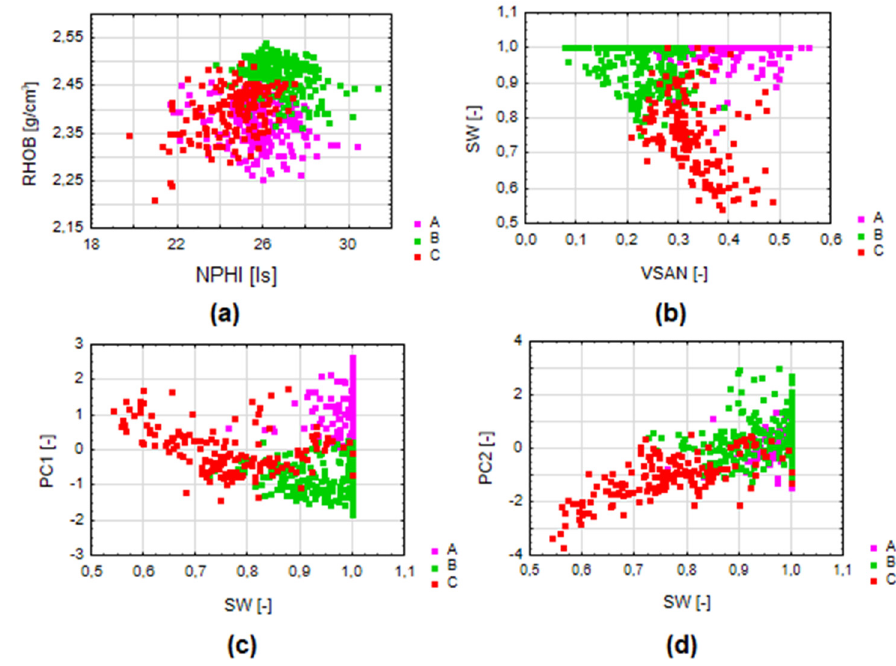
Figure 2. Clustering results (different colours on the graphs) in the relation to the standard well logs interpretation, W-1 well: ( a ) row data relation RHOB vs. NPHI; ( b ) volume of quartz mineral content VSAN in the relation to the water saturation SW; ( c ) water saturation SW relation to the PC1; ( d ) water saturation in the relation of PC2.